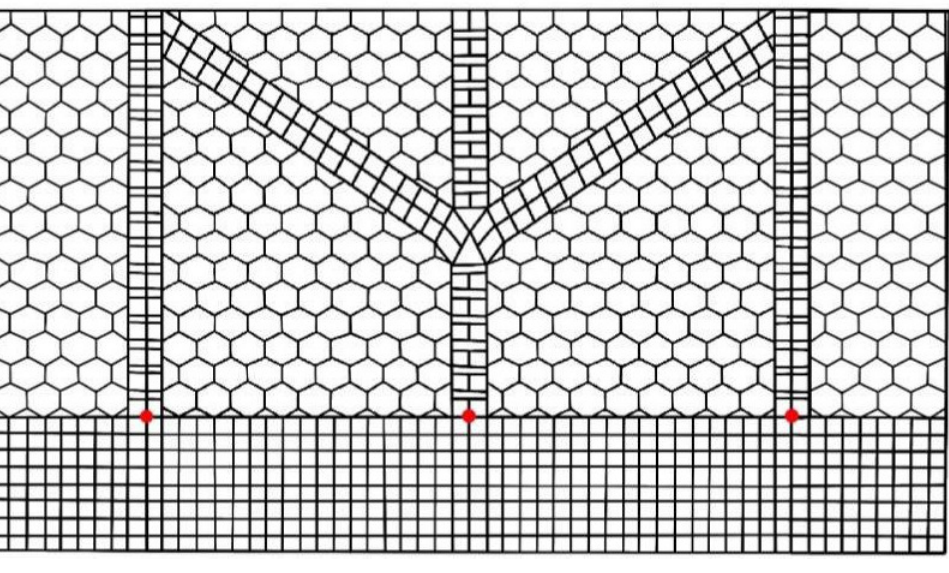
Figure 28. ( a ) Combined displacement clouds under the self-weight of the model one increased col- umn; ( b ) Numerical diagram of deflection under the permanent load plus an external load of the model one increased column; ( c ) Clouds of tensile and compressive stresses under the permanent load plus an external uniform load of the model one increased column.